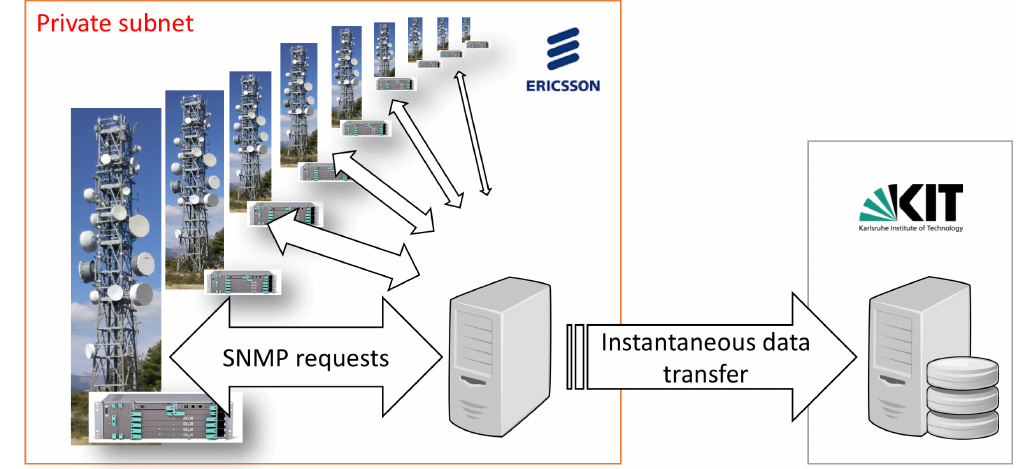
Figure 1. Overview of the basic concept of our real-time CML data acquisition system at Ericsson. The CMLs are shown together with one main control unit per site (this is a simplified example) which can be identified via its private IP address. The DAQ server inside the private subnet requests the CML signal levels via SNMP and immediately sends the data to a database server at our institute